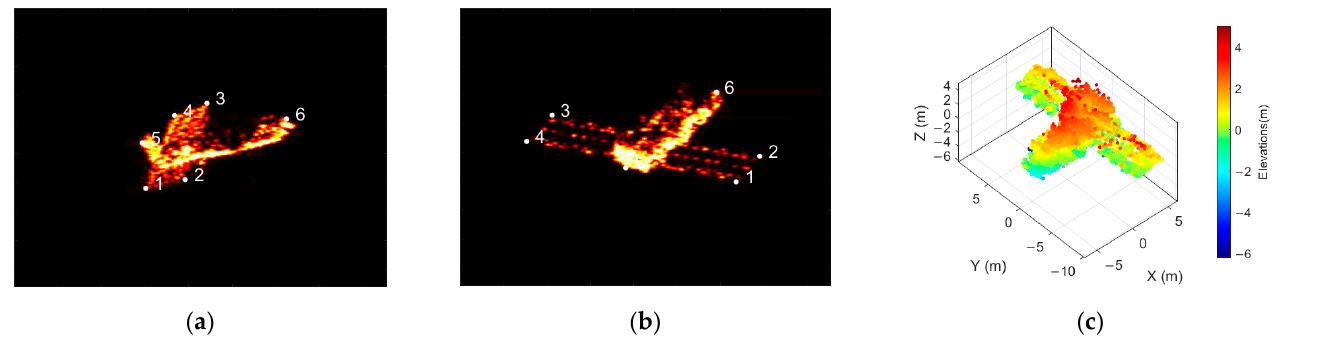
Figure 11. ISAR images and the reconstructed 3D geometry of Tiangong-1. ( a ) the first frame and ( b ) the sixty-fourth frame of the ISAR image sequence, and ( c ) the reconstructed 3D geometry of Tiangong-1.